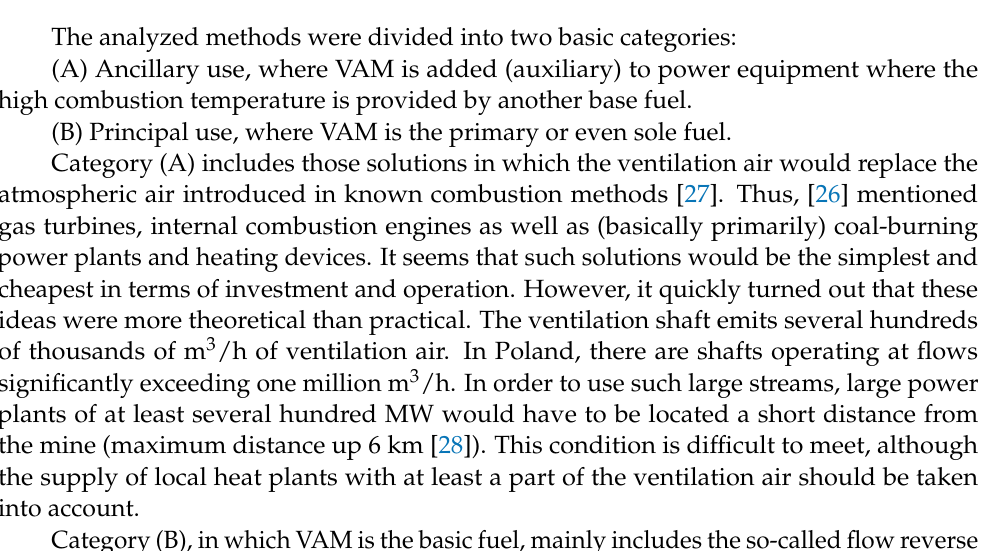
Figure 3. Scheme of combustion technologies of